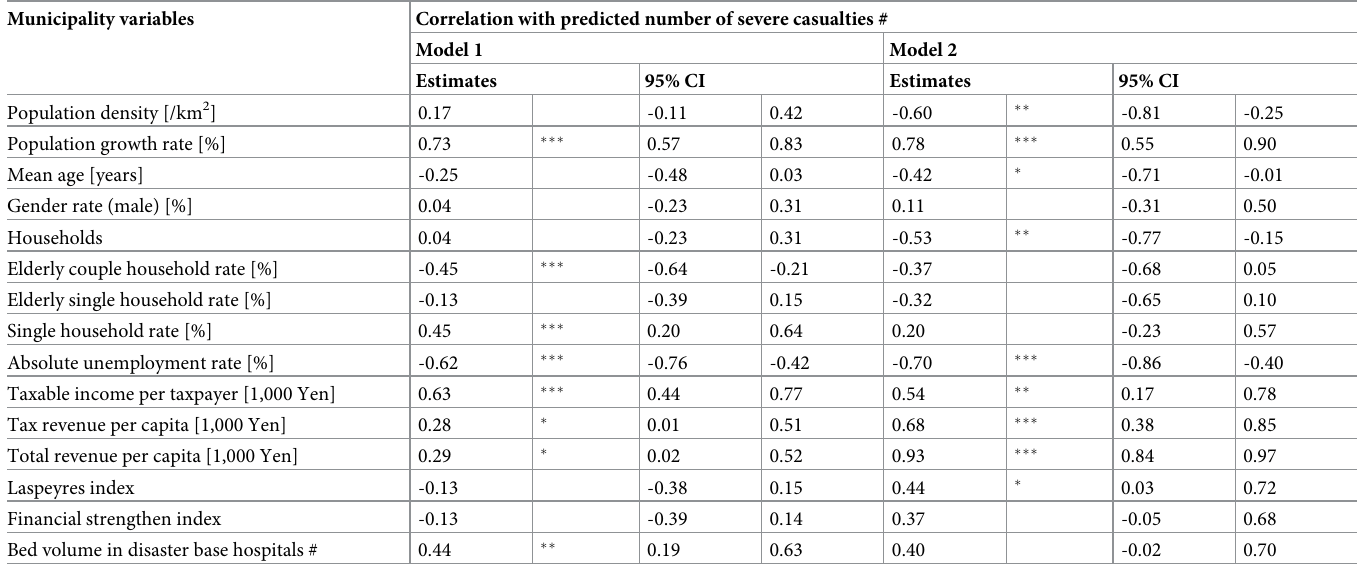
Table 2. The correlation between municipality variables and predicted number of severe casualties in a foreseeable Tokyo earthquake. Municipality variables